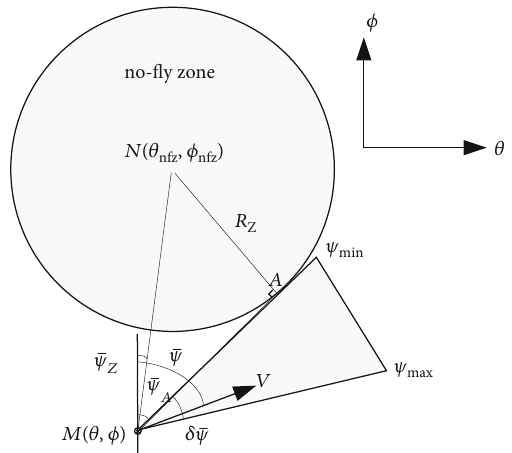
Figure 8: Relative relationship between the center of the no- fl y zone and the